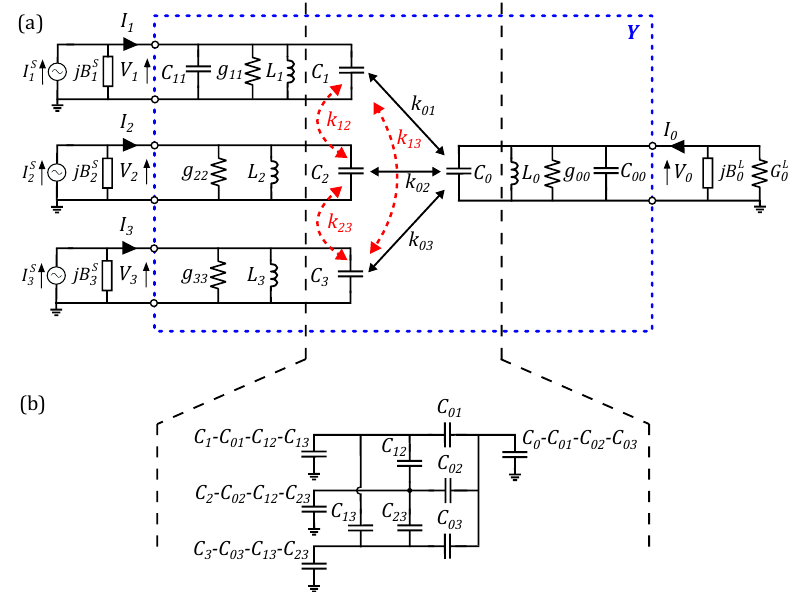
Figure 3. ( a ) Equivalent circuit of a capacitive wireless power transfer system with 3 transmitters (left) and a single receiver (right). The (desired) electric couplings between transmitters and receiver are depicted by the full arrows. The (undesired) cross-couplings between transmitters themselves are indicated by the dashed arrows. ( b ) Applied equivalent circuit for the simulation of the capacitive